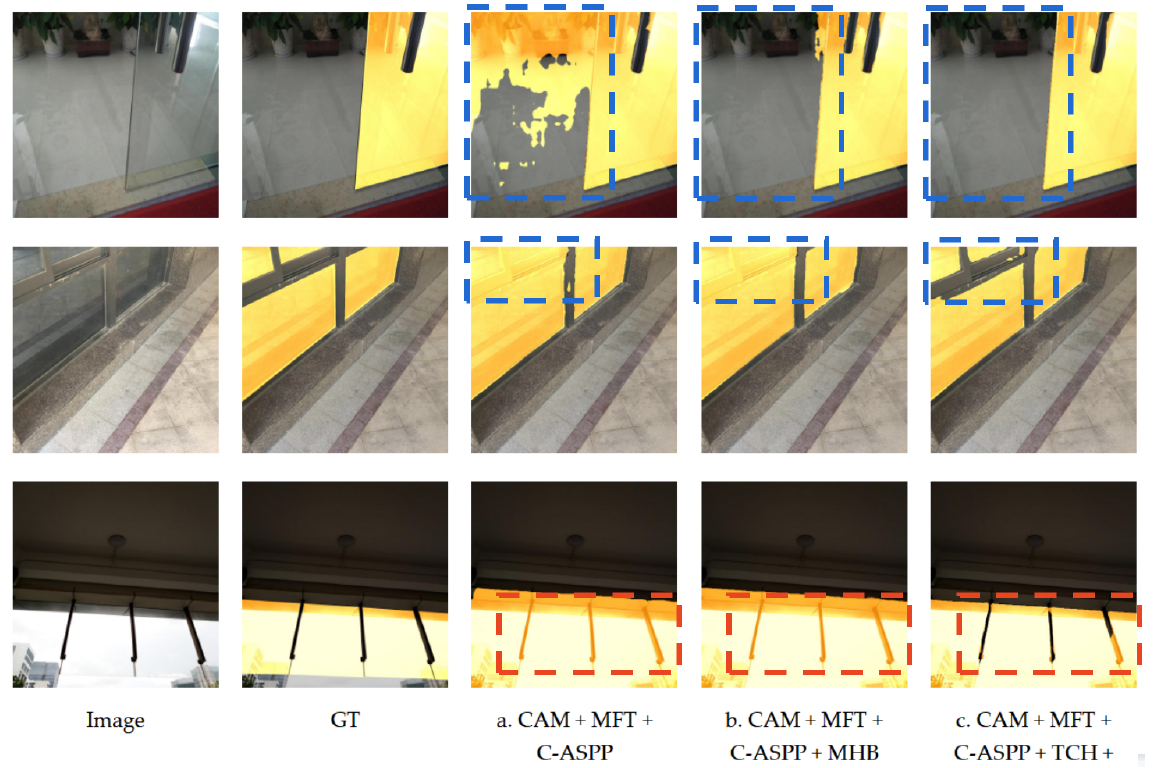
Figure 13. Comparison of experimental results of multiscale convolutional attention ablation; ( a ) does not use MFT, ( b ) uses self-multi-headed attention, and ( c ) uses multi-scale convolutional at- tention.